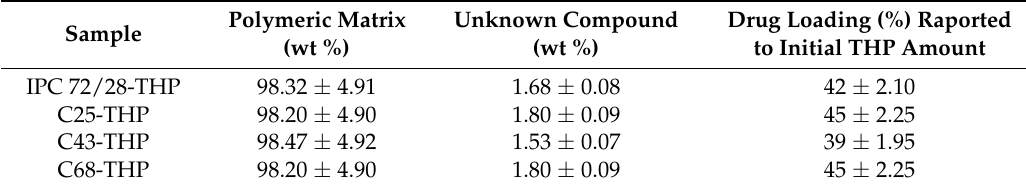
Figure 1. Partial least squares-discriminate analysis (PLS-DA) model images obtained for ( a ) interpolymeric complexes (IPC) 72/28 ( b ) C43 and ( c ) C68 copolymers. Table 1. Evaluation of the theophylline (THP) loading of the IPC and graft copolymers by the near infrared (NIR) method.